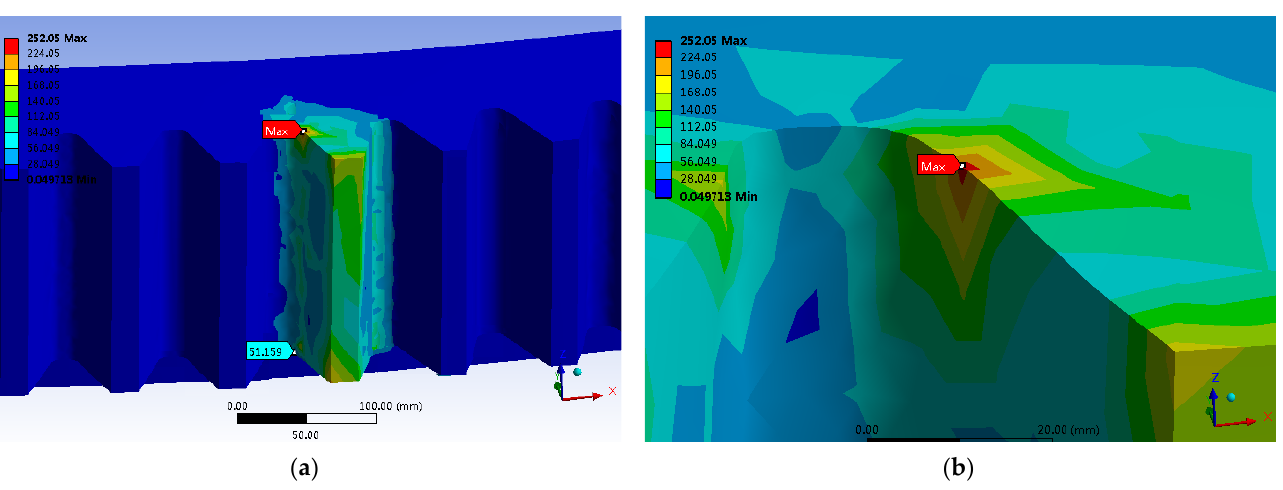
Figure 17. Stress at the meshing position of the large gear ring: ( a ) Overall stress distribution dia- gram; ( b ) magnified diagram of local stress. ( b ) magnified diagram of local stress.